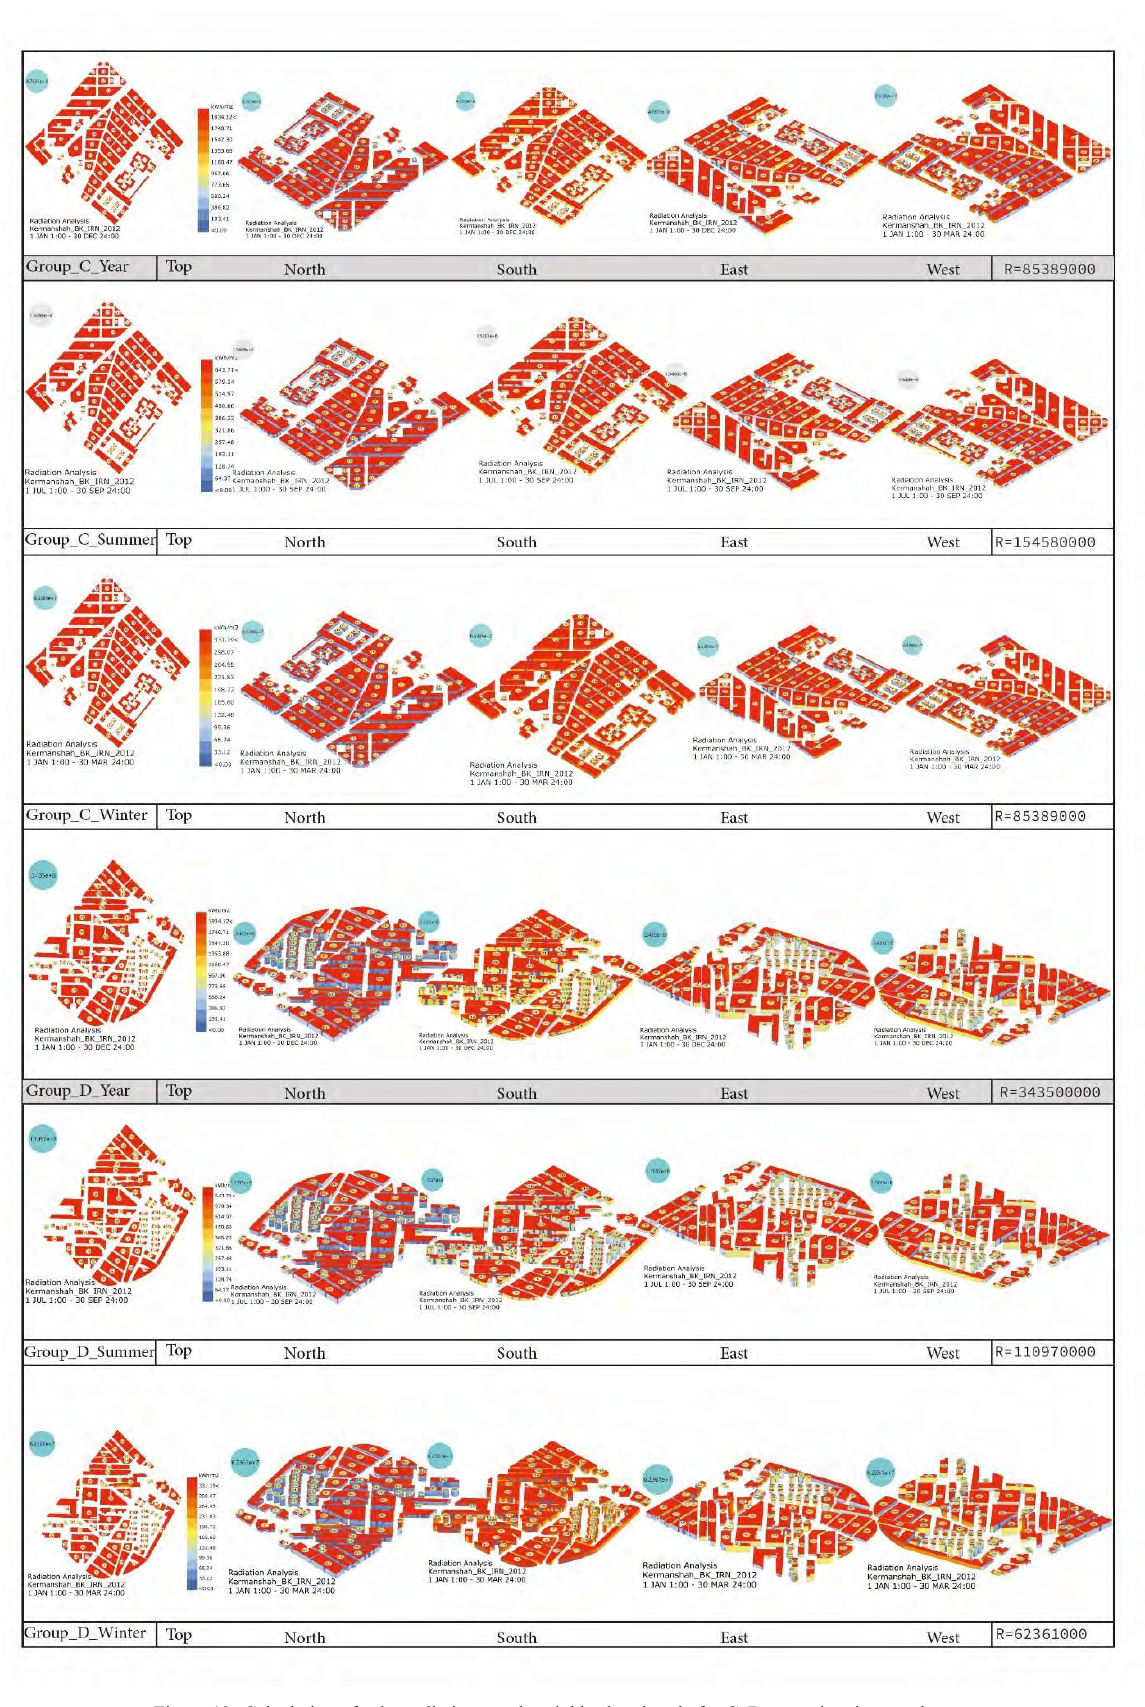
Figure 12- Calculation of solar radiation at sub-neighborhood scale for C_D group in winter and summer Based on the evaluation of the patterns in different seasons in Figures 11 and 12, the facade surface data support our previous hypothesis that the energy absorption was constant compared to other surfaces in different directions.